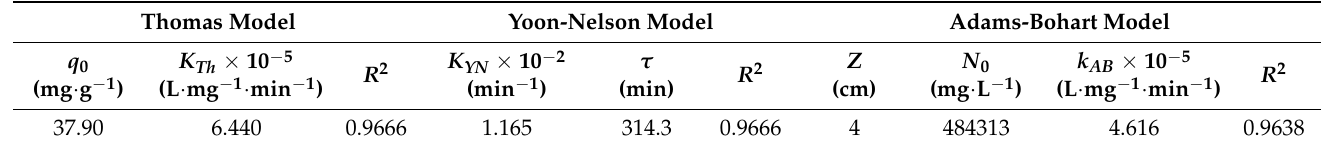
Table 4. Model parameters for RMCR fixed-bed columns calcium ions. Thomas Model Yoon-Nelson Model Adams-Bohart